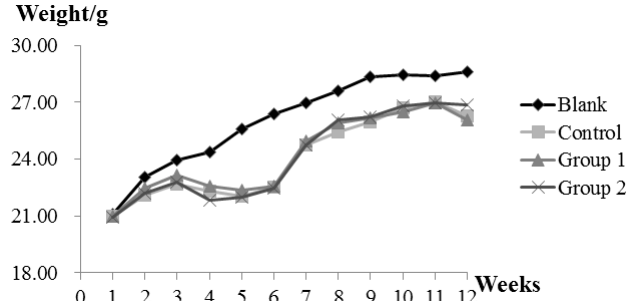
Figure 1. The effect of Angelica sinensis root (ASR) extract on body weight in the Azoxymethane/Dextran sodium sulphate (AOM/DSS) mouse model. Body weights across all groups were measured once a week at a fixed time. Experimental treatments of each group are described as Materials and Methods; AOM/DSS Colitis Associated Carcinoma Mouse Model; and Experimental Procedures.